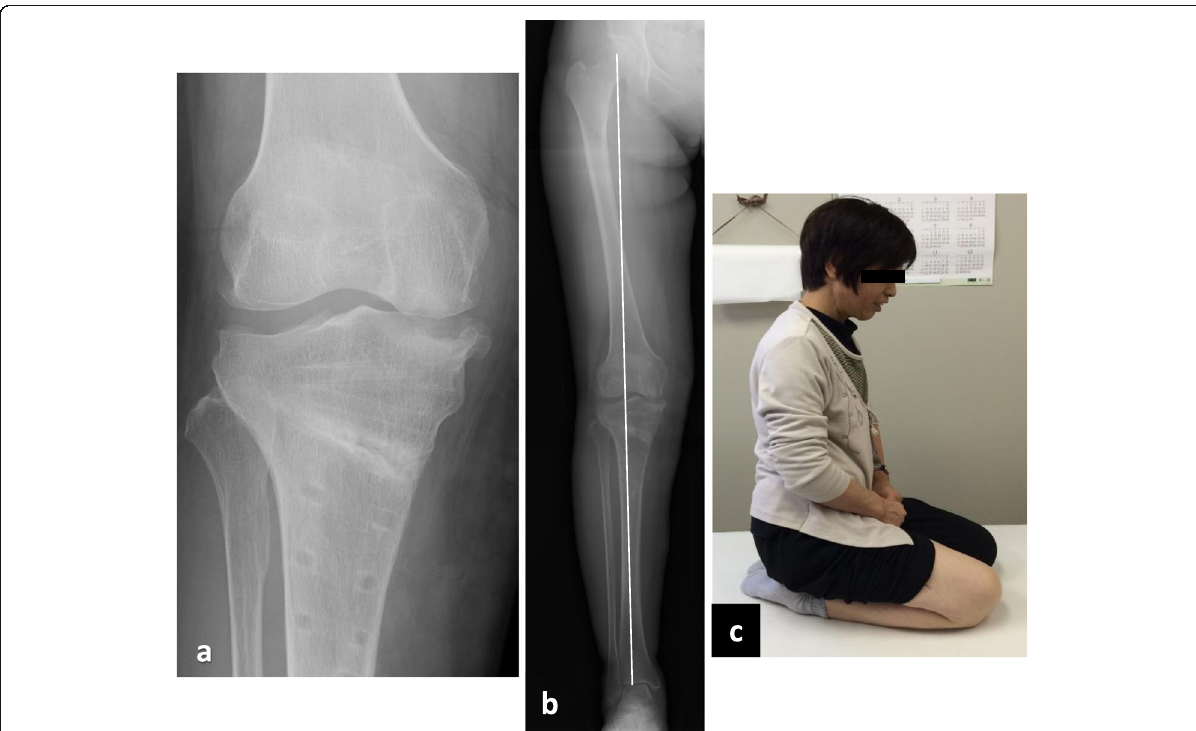
Fig. 4 The case at last follow-up (three years after OWHTO). a The AP standing radiograph of the knee. b The AP standing radiograph of the whole leg. The WBLR was 61.5%, and the lower leg alignment was maintained. c The patient could sit Japanese style. The Oxford knee score